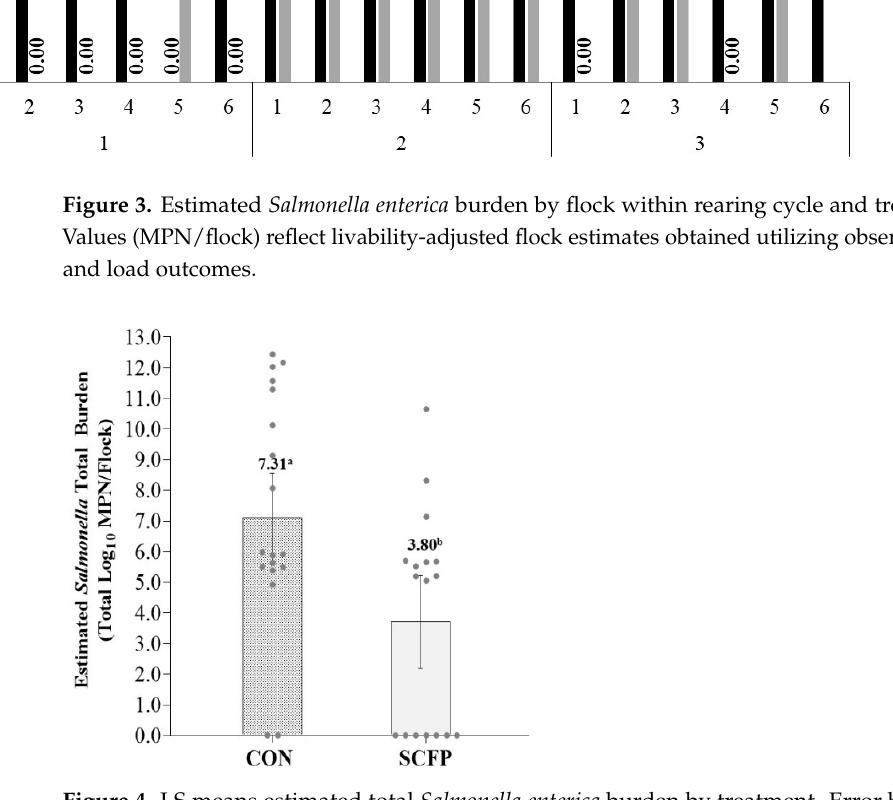
Figure 4. LS means estimated total Salmonella enterica burden by treatment. Error bars reflect 95% confidence interval with significant differences denoted by superscripts a,b at p < 0.05.